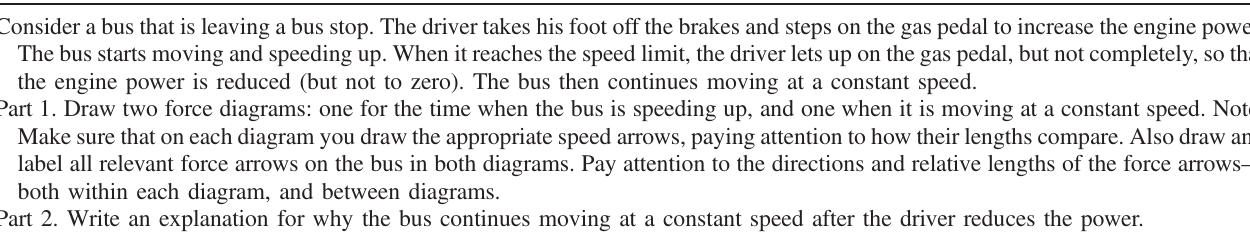
TABLE I. The prompt for the written explanation task on the final exam. Consider a bus that is leaving a bus stop. The driver takes his foot off the brakes and steps on the gas pedal to increase the engine power. The bus starts moving and speeding up. When it reaches the speed limit, the driver lets up on the gas pedal, but not completely, so that the engine power is reduced (but not to zero). The bus then continues moving at a constant speed. Part 1. Draw two force diagrams: one for the time when the bus is speeding up, and one when it is moving at a constant speed. Note: Make sure that on each diagram you draw the appropriate speed arrows, paying attention to how their lengths compare. Also draw and label all relevant force arrows on the bus in both diagrams. Pay attention to the directions and relative lengths of the force arrows — both within each diagram, and between diagrams. Part 2. Write an explanation for why the bus continues moving at a constant speed after the driver reduces the